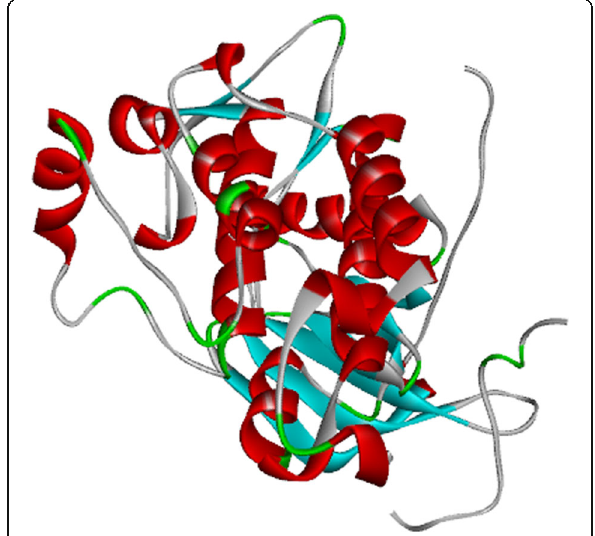
Fig. 2 3D structure of the prepared EGFR